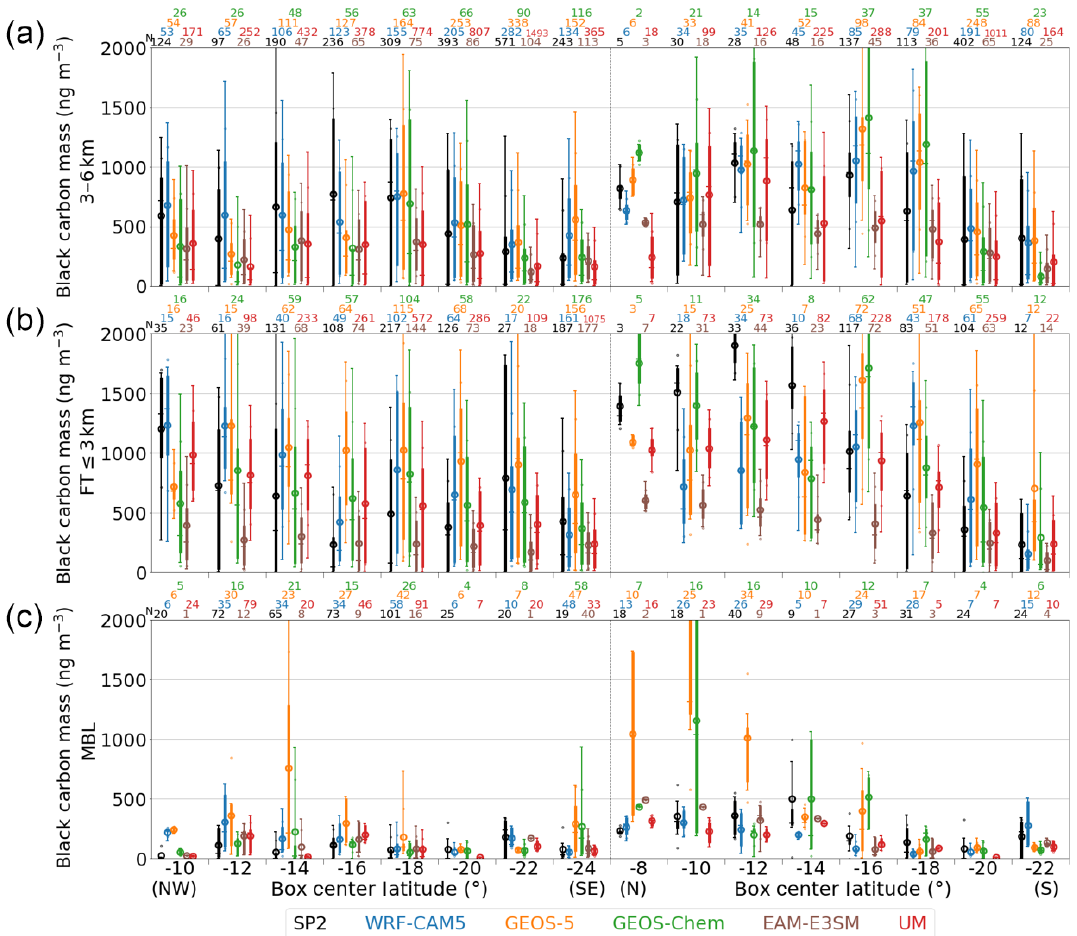
Figure 6. Black carbon mass concentrations compared between observations (black) and models (colors) for (a) 3–6km, (b) the top of MBL to 3km and (c) the MBL. The left-hand side of each panel corresponds to the eight diagonally aligned boxes of the routine flight path, and the right-hand side to the eight meridionally aligned ones described in Sect. 3.2 and Fig. 2. See Fig. 4 for a description of each bar and